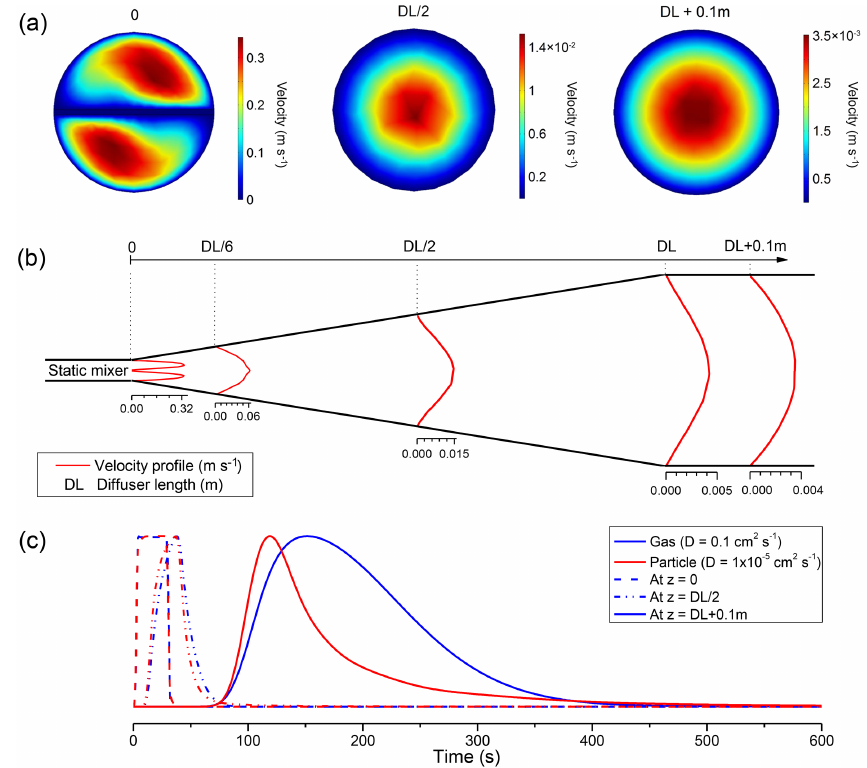
Figure 6. COMSOL simulated velocity field at the reactor inlet under isothermal conditions. Simulations were performed for the actual CPOT design: a 15 ◦ diffuser cone coupled to a static mixer. The velocity magnitude at various axial positions is shown in panel (a) , and 1-D axial velocity profiles within the “inlet-affected” region are shown in panel (b) . The velocity magnitude in panel (b) is presented on the axis below each velocity profile. Note that DL indicates diffuser length (53.3cm). Panel (c) shows the normalized residence time of vapor molecules and monodisperse particles at various axial positions. A 30s square wave pulse is used as the